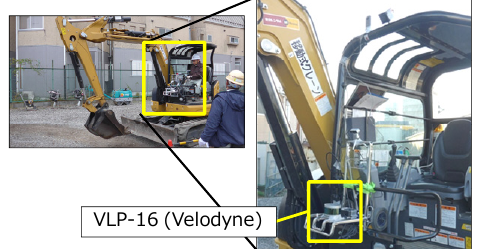
Figure 9. Laser scanner mounted on a construction vehicle